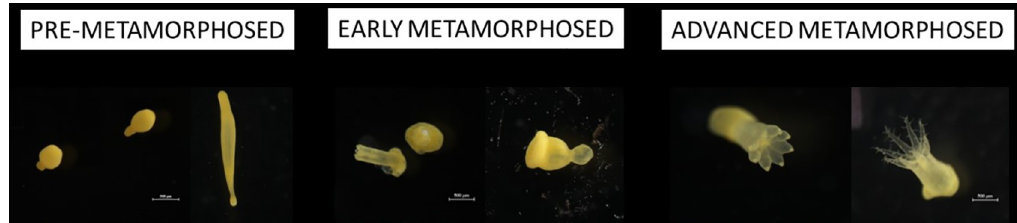
Fig 1. Morphological classification of R . f . fulvum planulae early developmental stages. The planulae were classified into four main developmental stages: pre-metamorphosed, early metamorphosed, advanced metamorphosed polyps with short tentacles and advanced ones with long